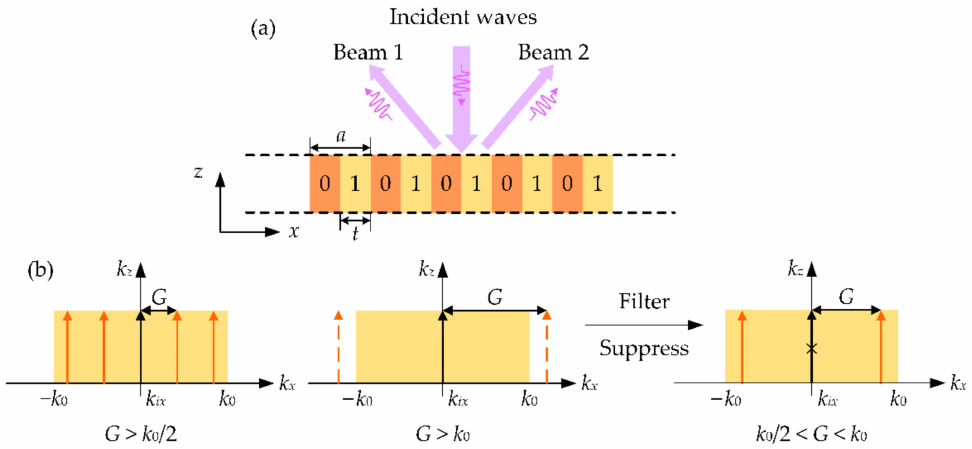
Figure 1. ( a ) Schematic illustration of a beam splitter based on the ABM. ( b ) Diagram of realizing a beam splitter in the ABM. The black cross on the black arrow indicates that the specular reflection waves are totally